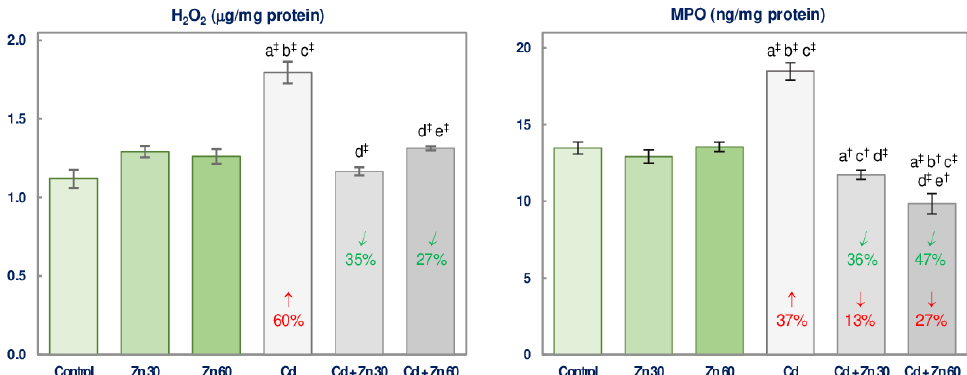
Figure 4. The concentrations of hydrogen peroxide (H 2 O 2 ) and myeloperoxidase (MPO) in the brain tissue of male rats after 6-month treatment with cadmium (5 mg Cd/L) and/or zinc (30 or 60 mg Zn/L) via drinking water. Data are shown as mean ± standard error (SE) for 8 animals. Statistically significant differences: a vs. Control group; b vs. Zn 30 group; c vs. Zn 60 group; d vs. Cd group; e vs. Cd + Zn 30 group; † p < 0.01; ‡ p < 0.001. The values inside the bars express the percentage changes vs. the control group ( ↓ , decrease; ↑ , increase;) or Cd group ( ↙ , decrease). Table 4. Interactive and main effects of cadmium (Cd) and zinc (Zn) on the concentrations of hydrogen peroxide (H 2 O 2 ) and myeloperoxidase (MPO) in the brain tissue of male rats 1,2 .